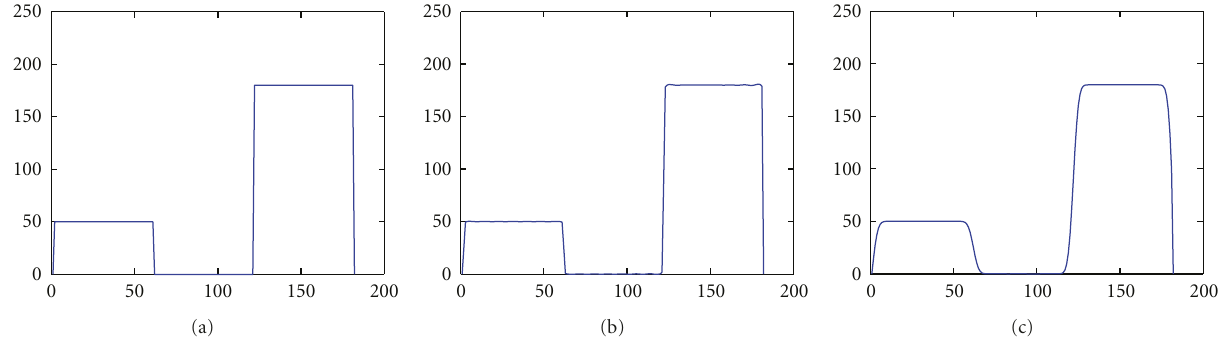
Figure 3: (a) The grayscale value of the 36th row of Figure 1(a), (b) the Fourier series with 300 terms, and (c) di ff used result by di ff usion equation at t = 3.